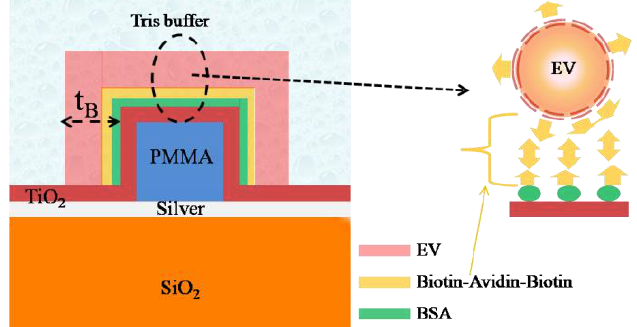
Figure 9. Cross sectional view of the proposed sensor functionalized for EV sensing. The left side image represents enlarged view of the model used for EV detection.